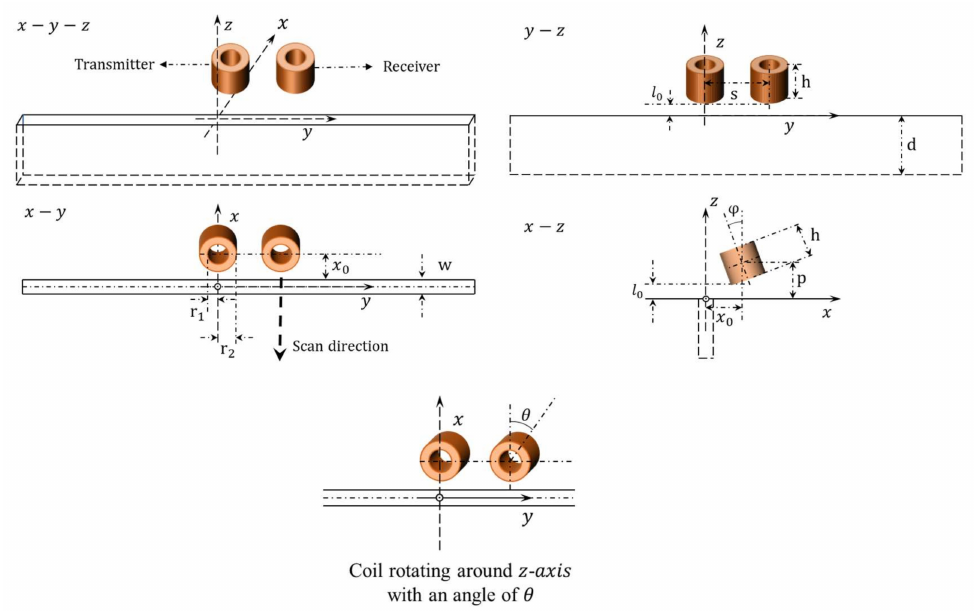
Figure 2. Tilted eddy current T-R sensor scanning across (x direction) and through the centre of a long surface crack slot on the conductive